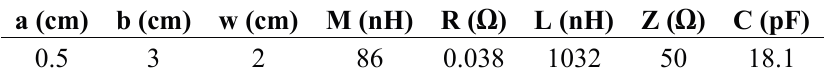
Table 1. Parameters of the Rogowski Coil.